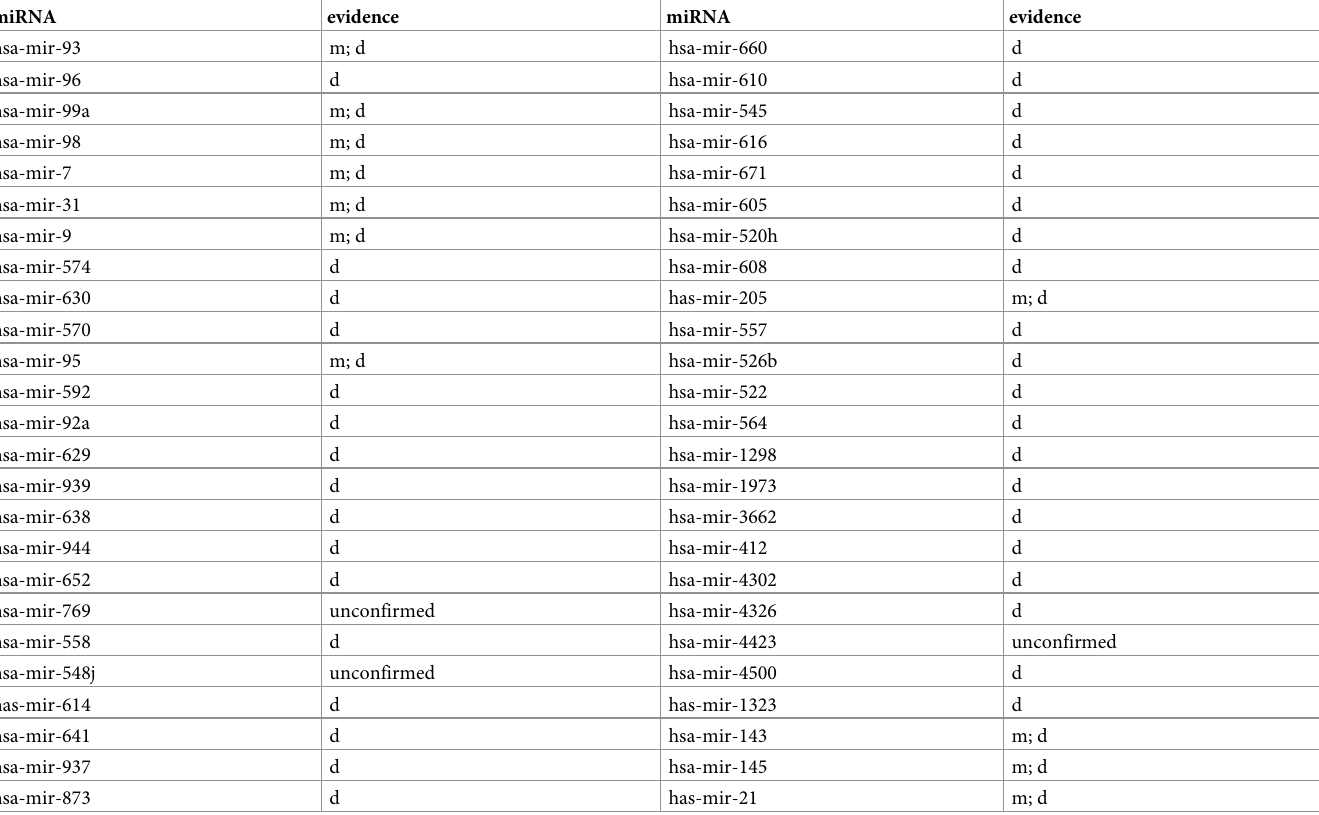
Table 1. The top 50 potential miRNAs associated with lung neoplasms.